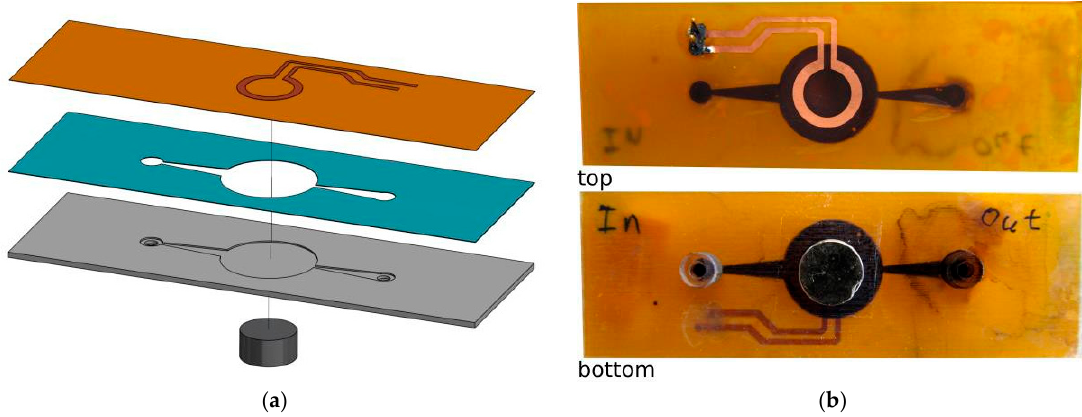
Figure 2. ( a ) Explosion drawing of the assembly. Orange: Flexible PCB. Blue: Double sided adhesive tape. Grey: Microfluidic polymer channel. Bottom: Permanent magnet. ( b ) Top and bottom view of the device. The microfluidic channel is filled with black ink for better